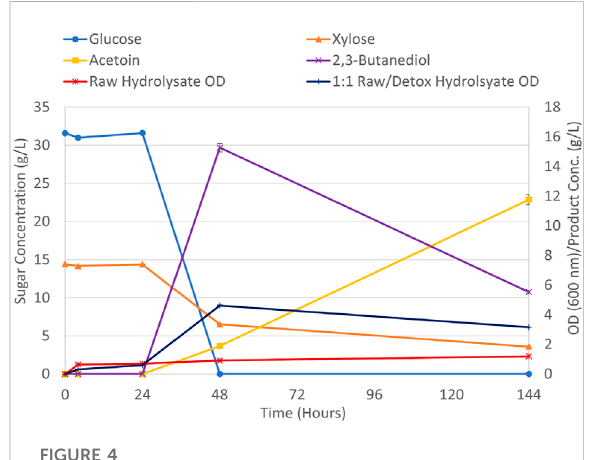
FIGURE 4 Sugar consumption, product generation, and biomass growth for the aerobic fermentation of a 1:1 (v/v) raw/detoxi fi ed pretreated SSB hydrolysate.